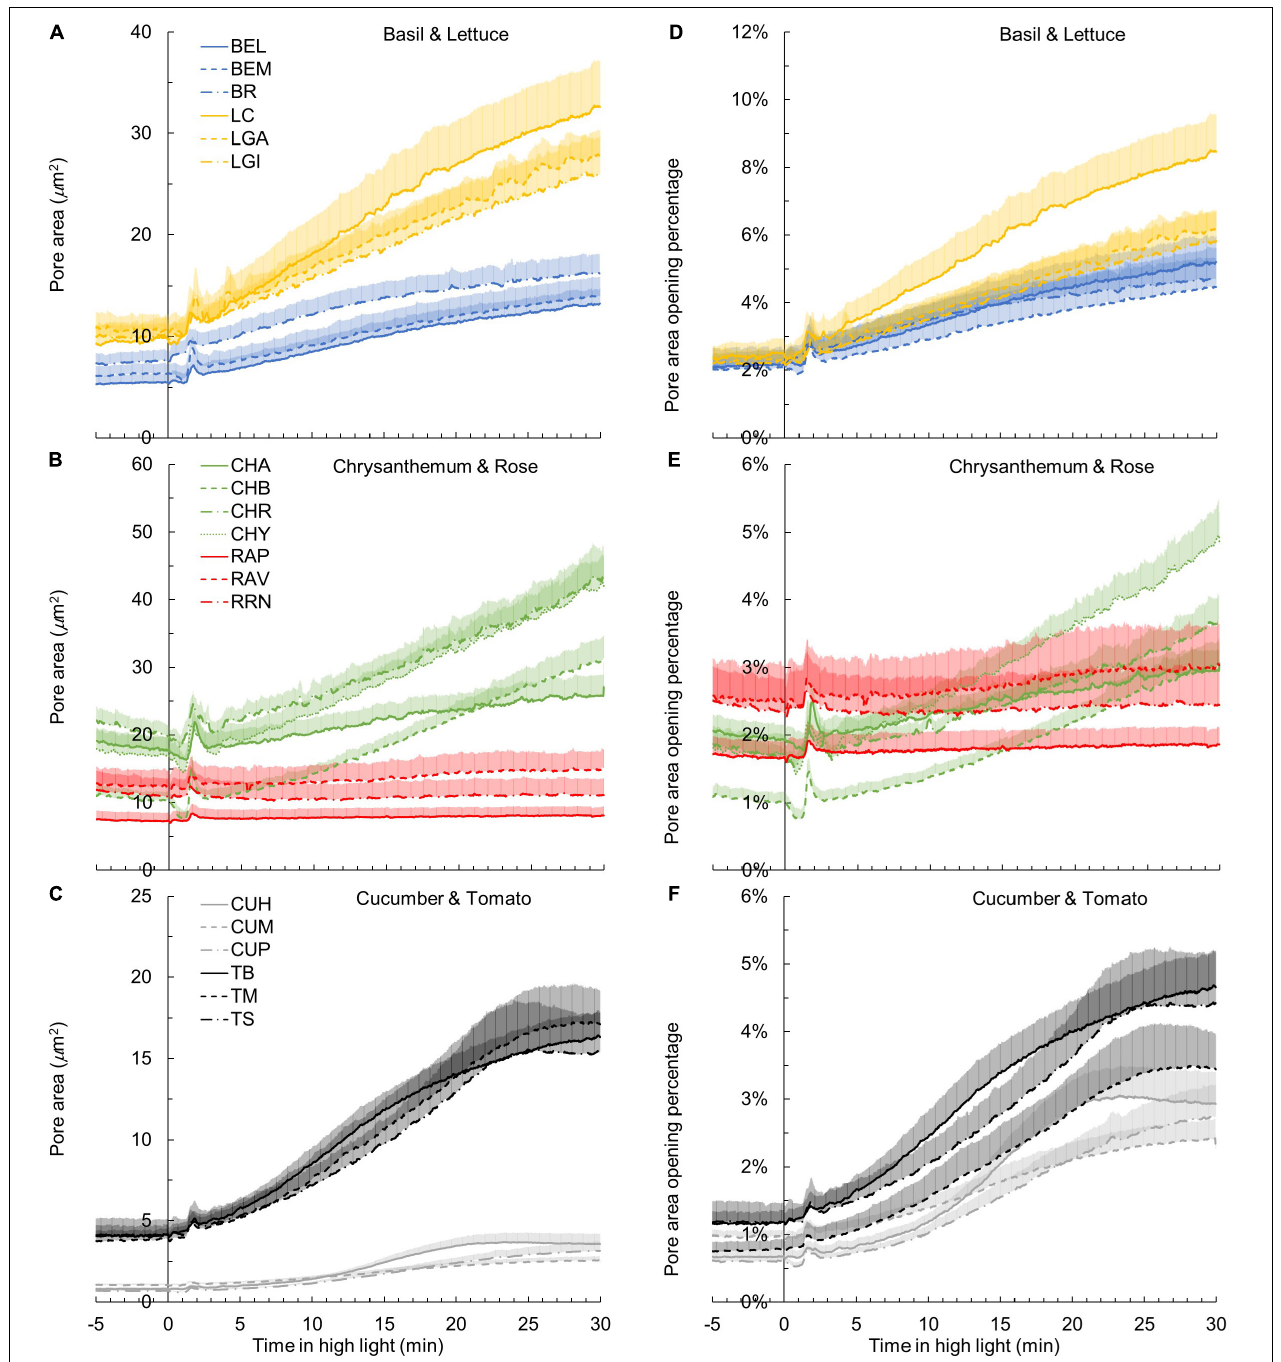
FIGURE 6 | Kinetics of pore area opening (A–C) and pore area opening as a percentage of the theoretical maximum pore area (D–F) in response to a single-step change in irradiance in 19 horticultural genotypes ( A,D : basil and lettuce; B,E : chrysanthemum and rose; C,F : cucumber and tomato; refer to Table 1 for full genotype names). Time zero indicates the moment when irradiance was increased from 50 to 1000 µ mol m − 2 s − 1 . Line colors represent crop species, while line types differentiate between cultivars. Each curve represents the mean of 7–9 individual plants (mean +